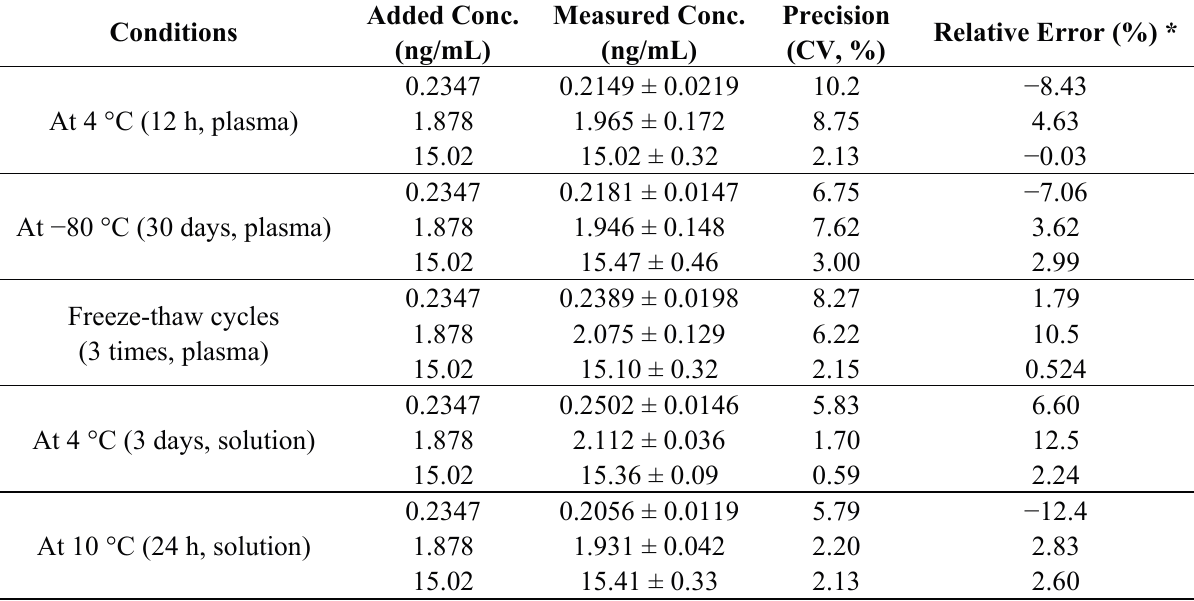
Table 2. The stability of sinomenine in human plasma and solution (Mean ± SD, n = 5).